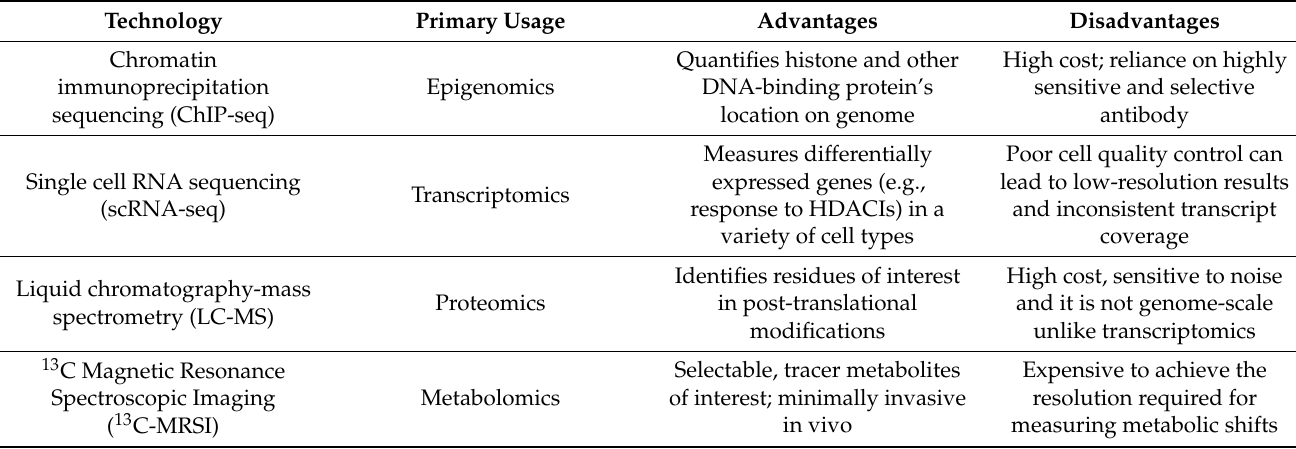
Table 2. Table summary of usage, advantages, and disadvantages of relevant technologies for HDAC studies.